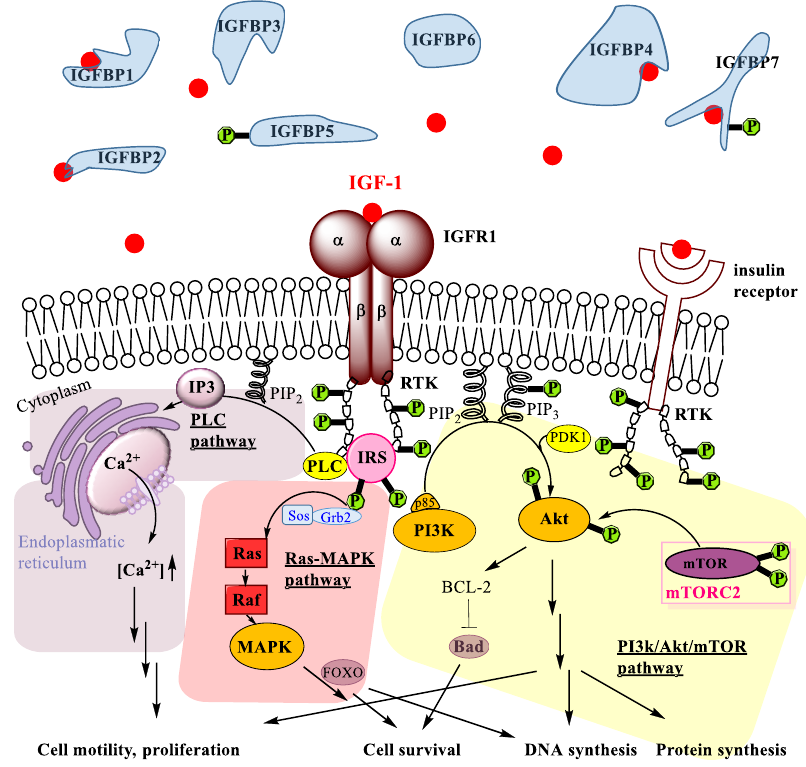
Figure 1. Signalling pathways activated through IGF-1 binding to its receptor IGFR1. PI3K/Akt/mTOR pathway (shaded yellow); Ras-MAPK pathway (shaded red); and PLC pathway (shaded violet). Further explanations are given in the main text.